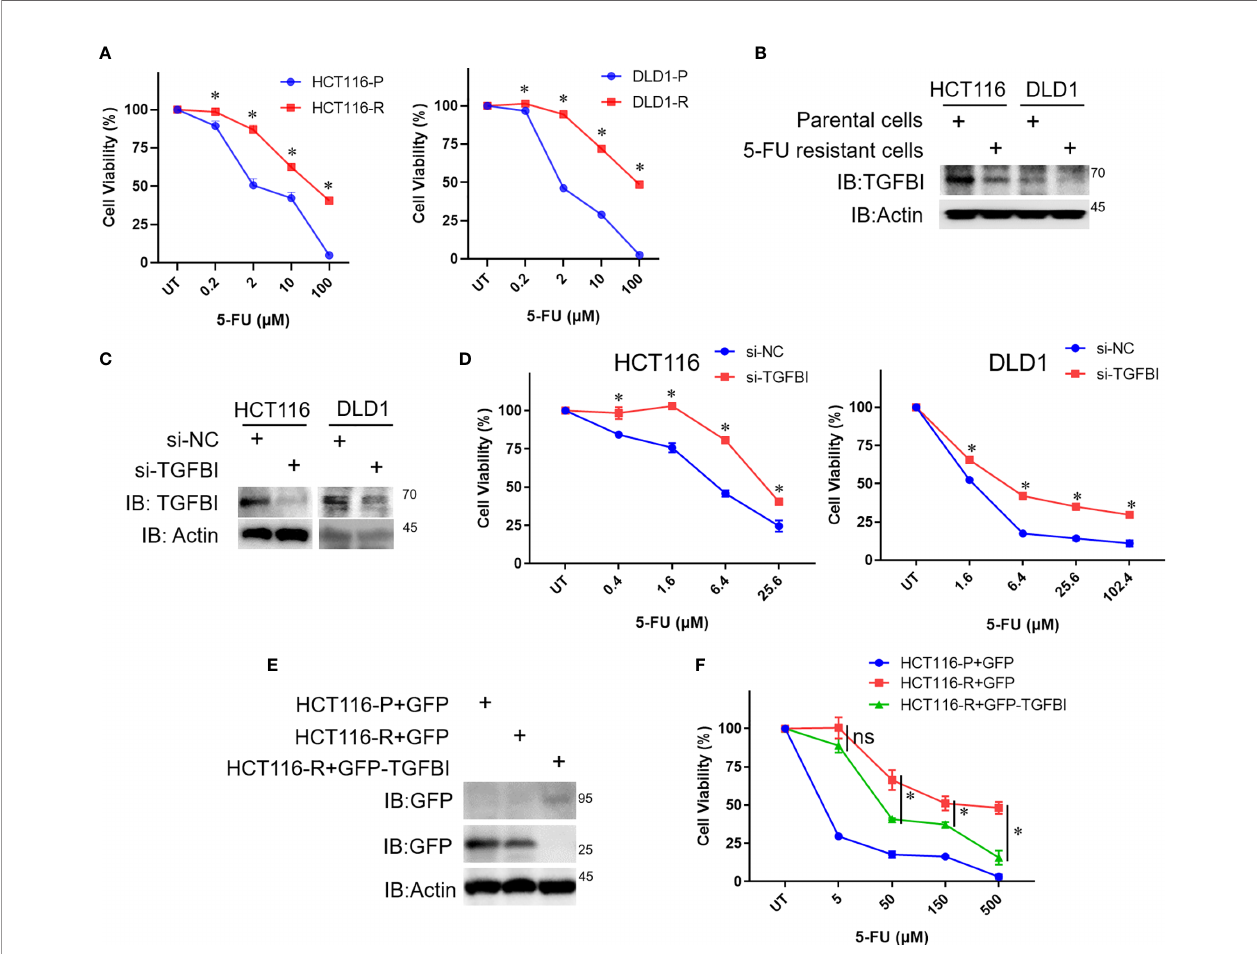
FIGURE 10 | The relationship between TGFBI level and 5-FU sensitivity of CRC cells. (A) The parental cells and 5-FU resistant cells of HCT116 and DLD were treated with different concentrations of 5-FU for 72h, then the media were dumped off, cells were subjected to the 3-(4,5)-dimethylthiahiazo (-z-y1)-3,5-di- phenytetrazoliumromide (MTT) assay. Data were calculated from three independent experiments and analyzed by one-way analysis of variance (data shown are the means ± s.e.m., * p < 0.05). (B) Whole-cell lysates were derived from the parental cells and 5-FU resistant cells and immunoblotted (IB) for TGFBI, with actin as a loading control. (C) HCT116 cells or DLD1 cells were transfected with si-NC or si-TGFBI in day 0 and day 2, 8 h after the second transfection, some of the cells were harvested to detect TGFBI knockdown ef fi ciency. The remaining cells were used for (D) . (D) Cells from (C) , which were transfected with si-NC or si-TGFBI twice, were treated with different concentrations of 5-FU for 72h, then cells were subjected to MTT assay. Data were calculated from three independent experiments and analyzed by one-way analysis of variance (data shown are the means ± s.e.m., * p < 0.05). (E) The parental cells of HCT116 were transfected with pEGFP, the resistant cells of HCT116 were transfected with pEGFP and pEGFP-TGFBI, respectively. Half of the cells were harvested to detect the expression of TGFBI using GFP-antibody after 24 h transfection. The remaining cells were used for (F) . (F) Cells from (E) , which were transfected with pEGFP or pEGFP-TGFBI were treated with different concentrations of 5-FU for 72h, then cells were subjected to MTT assay. Data were calculated from three independent experiments and analyzed by one-way analysis of variance (data shown are the means ± s.e.m., ns, no statistical signi fi cance by one-way analysis of variance, * p <